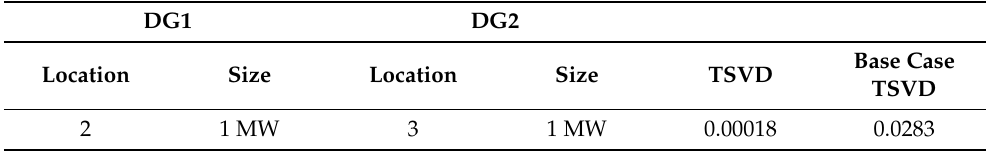
Table 2. Optimal location and size of DG units.